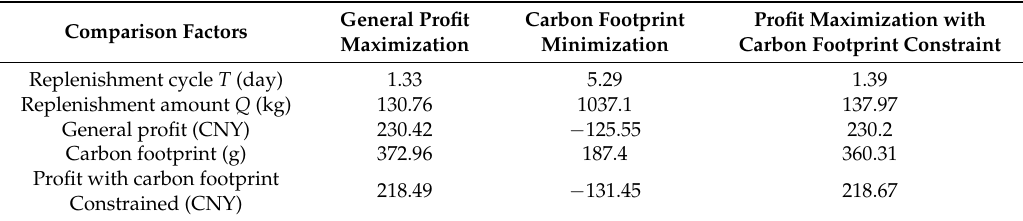
Table 5. The optimization performance in different objective functions. CNY, China